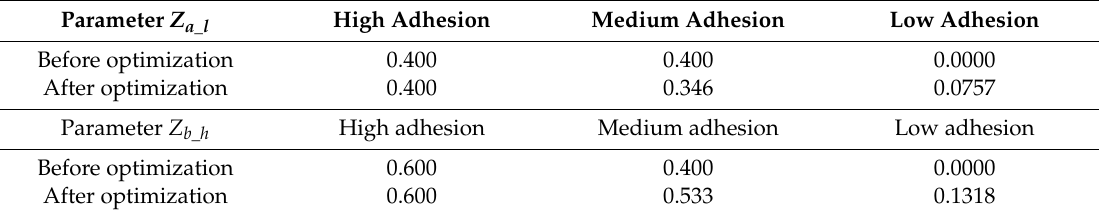
Table 4. Results of Z a-l and Z b-h after optimization.